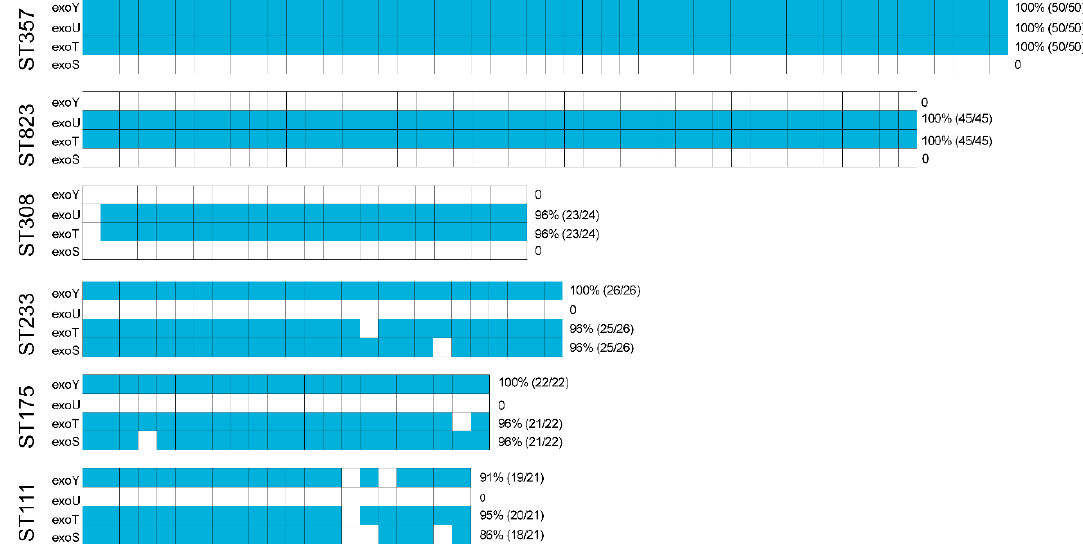
Figure A4. Virulence factors present in carbapenemase-producing P. aeruginosa isolates. The blue represents positive for virulence factor in the carbapenemase-producing P. aeruginosa isolates.